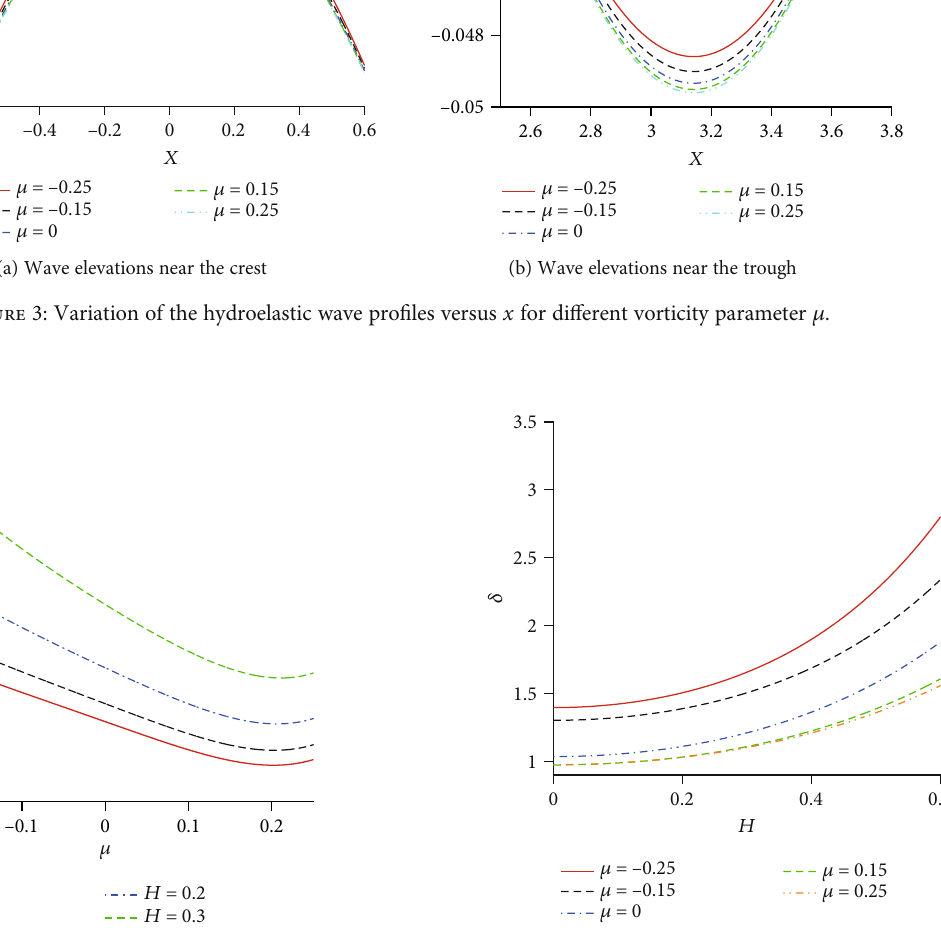
Figure 5: The in fl uence of the wave amplitude H on the phase Þ for di ff erent vorticity parameter μ . velocity δ ð = c 2 / c 2 0